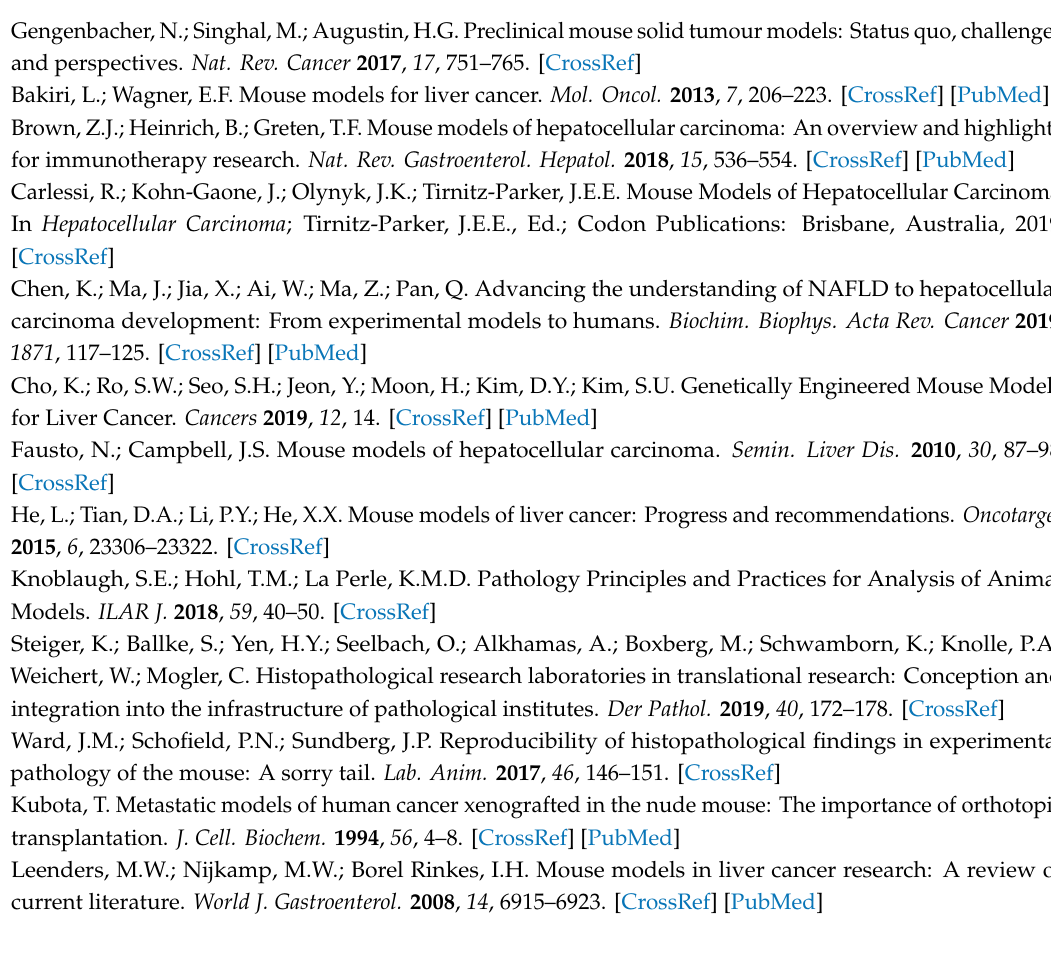
Figure S1: Additional lesions identified in GEMM, Table S1: Distribution of age and sex of